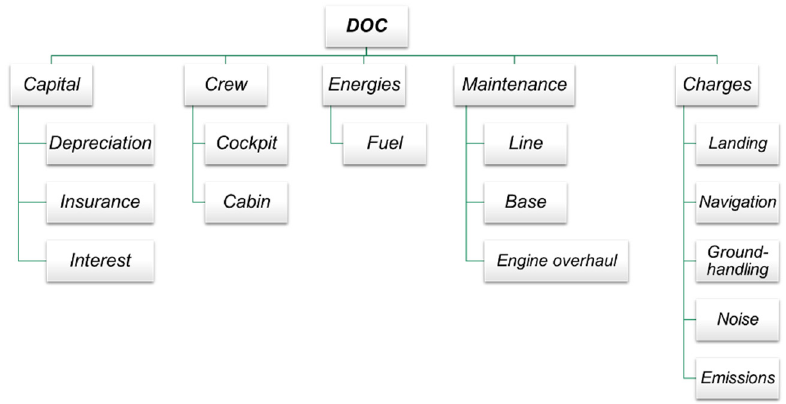
Figure 2. DOC breakdown.